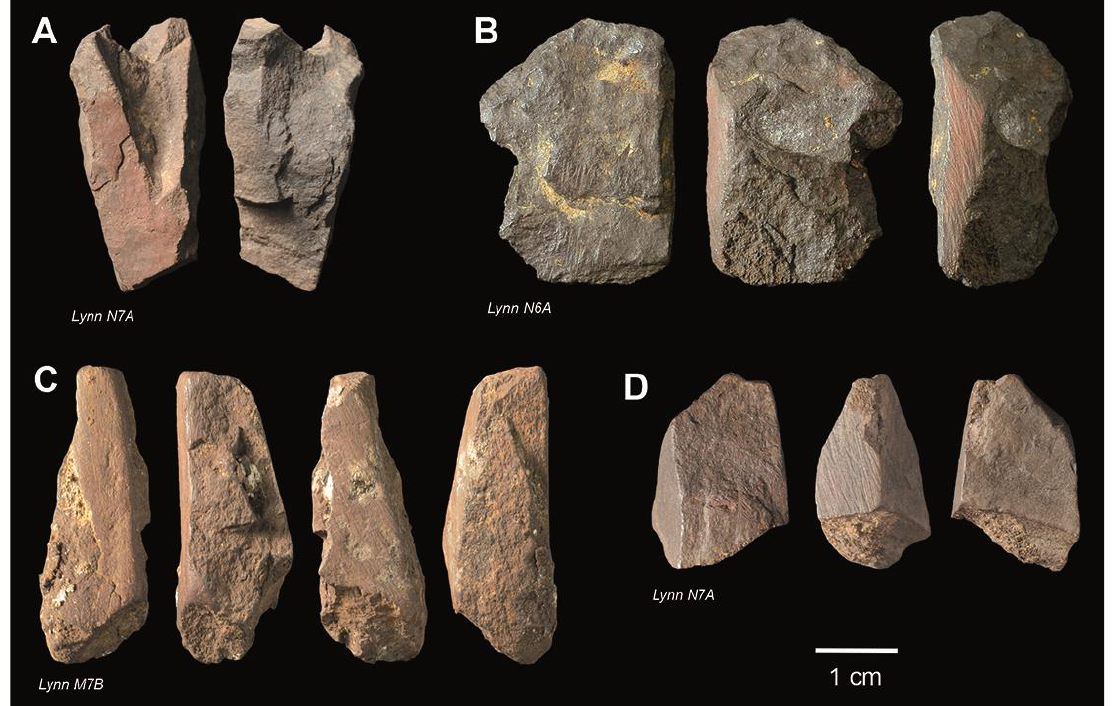
Figure 5 . A selection of ochre pieces from the stratigraphic unit Lynn illustrating the variability in raw materials and degree of processing (Diepkloof Rock Shelter). A: unmodified shale fragment with a lustrous patina (of natural origin) on one face. B & C: shale/ferricrete nodules with a ground facet.